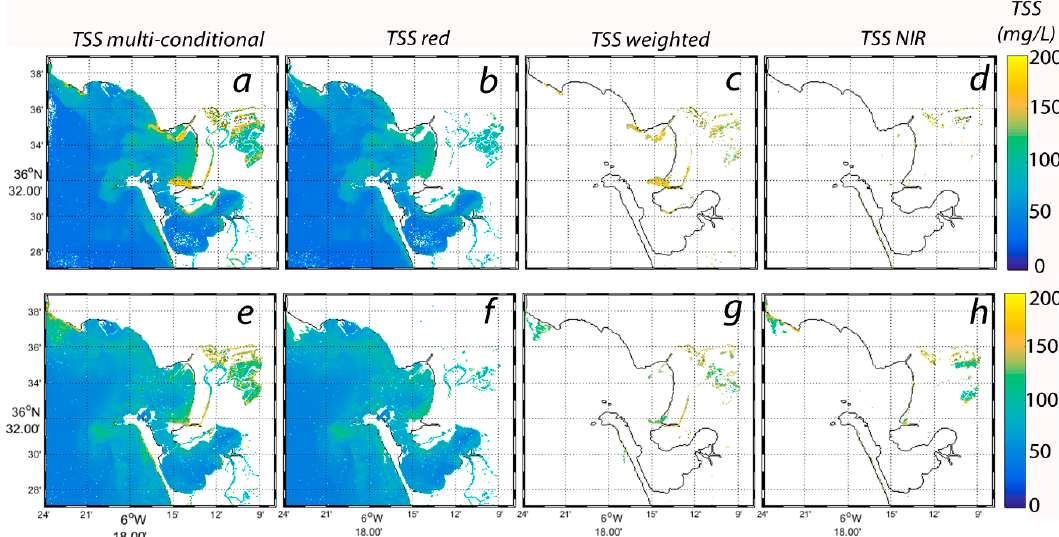
Figure 12. Total Suspended Solids (TSS) concentration (mg/L) derived from the multi-conditional algorithm for Sentinel-2 imagery using the red (664 nm) and near-infrared (NIR, 865 nm) bands after correction with ACOLITE (10 m spatial resolution) in Cadiz Bay on 19 December 2015 ( a – d ) and on 17 February 2016 ( e – h ).